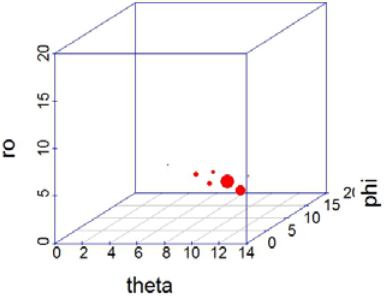
Figure 2. Parameter space of the Hough